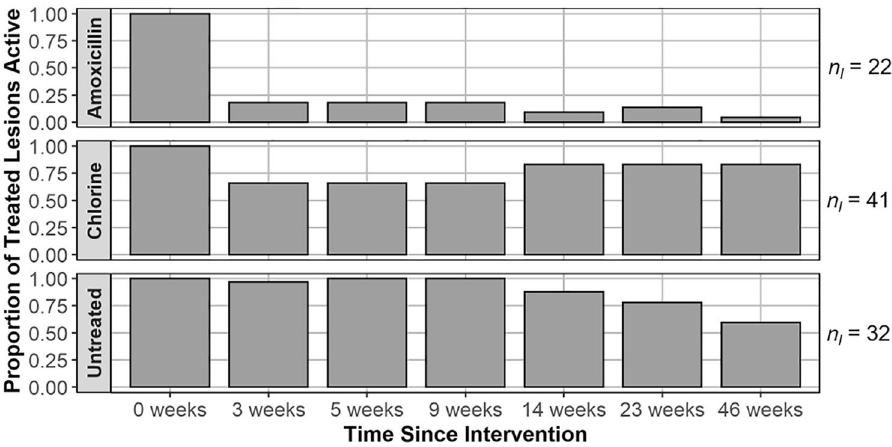
Figure 4. Proportion of initially treated disease lesions active on colonies by treatment group at each monitoring event, with n l indicating total number of lesions present across all colonies in the treatment group. Amoxicillin refers to the Base 2B plus amoxicillin treatment, chlorine refers to the chlorinated epoxy treatment, and untreated refers to the SCTLD-affected controls.